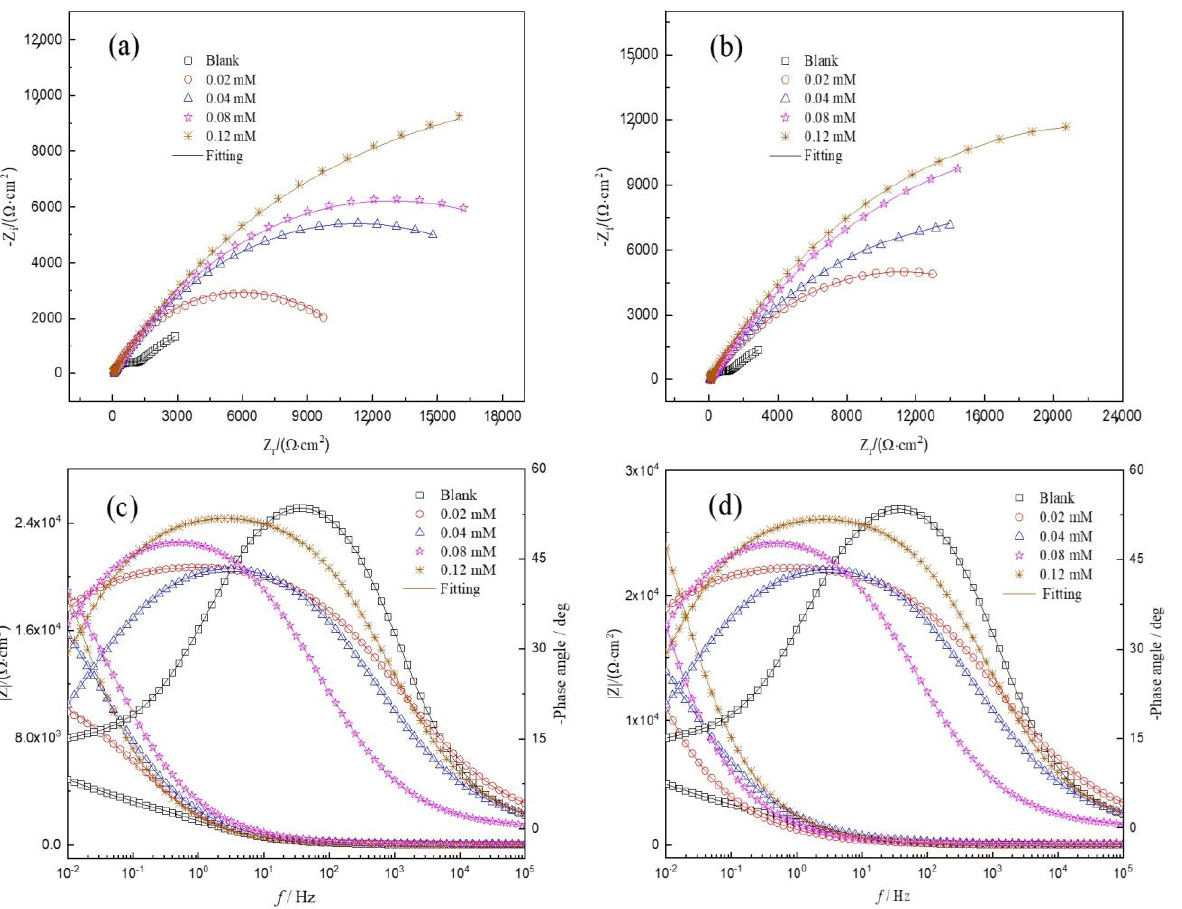
Figure 3. EIS plots for reinforced steel in SCP with perimidine derivatives at 25 °C. Top: Nyquist diagrams; bottom: Bode diagrams. PMD ( a ) and ( c ); SPMD ( b ) and ( d ).